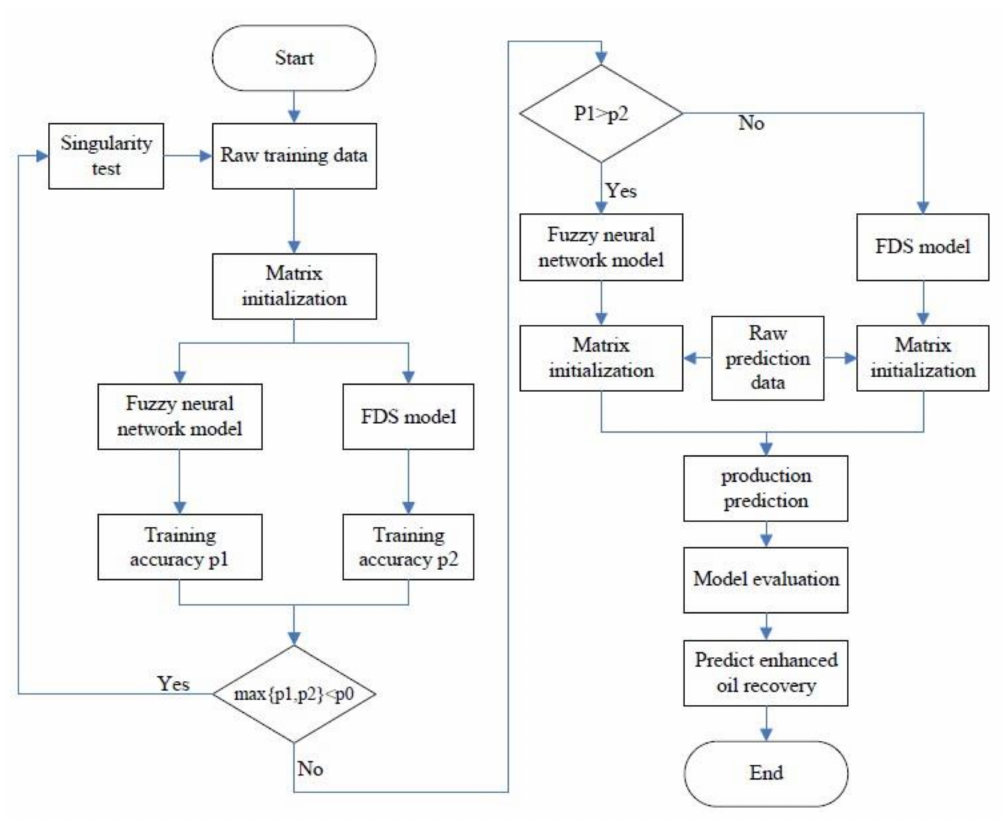
Figure 5. The structure flowchart of the FNN-FDS hybrid